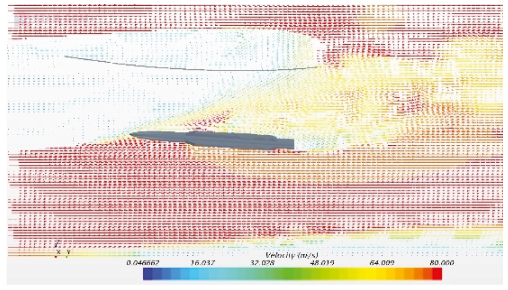
Figure 12: Flow fi eld velocity contour at 0.6s.